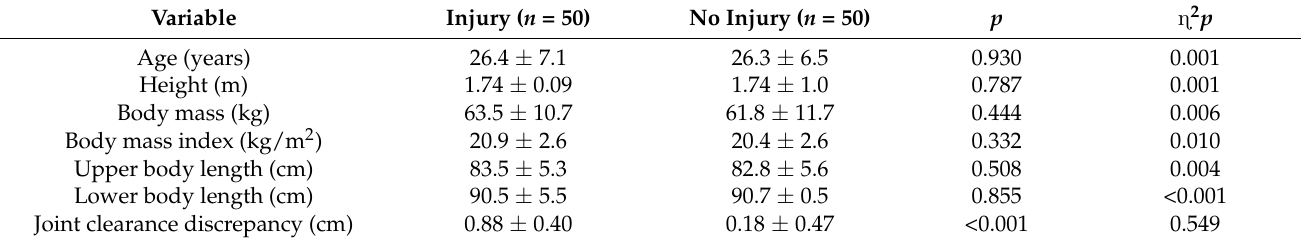
Table 1. Athletes’ age and anthropometric characteristics by group, i.e., those with and without a history of injury. Variable